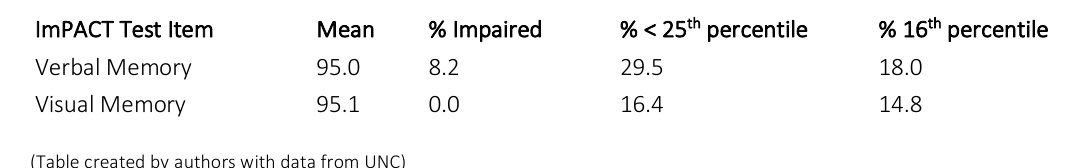
Table 4: Incoming Football Player ImPACT Test Scores (2010-12)